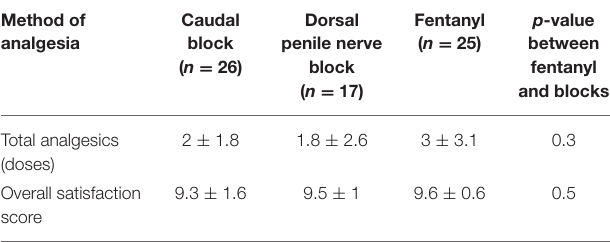
TABLE 4 | Home data via interview on POD